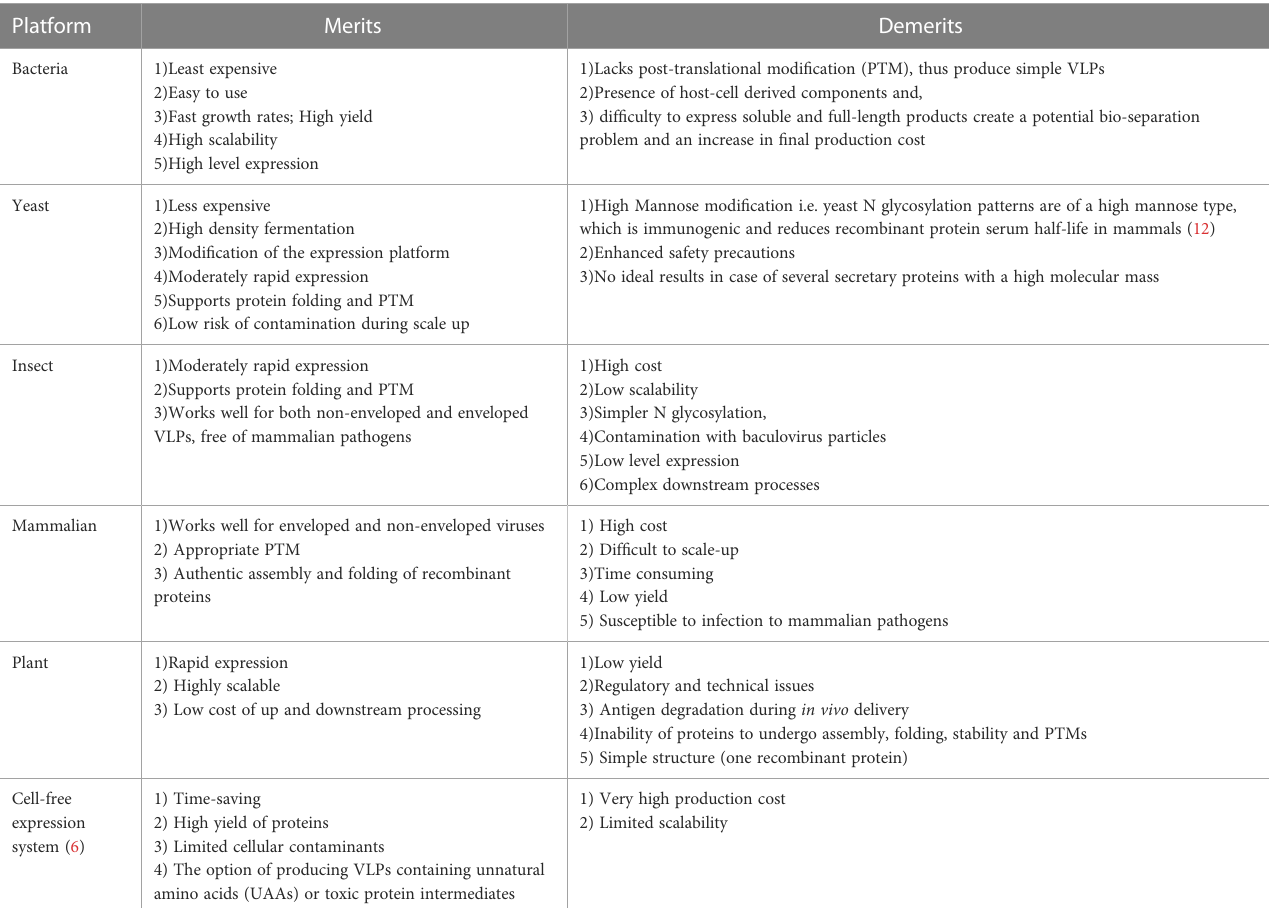
TABLE 1 Merits and demerits of various platforms of VLPs. Platform